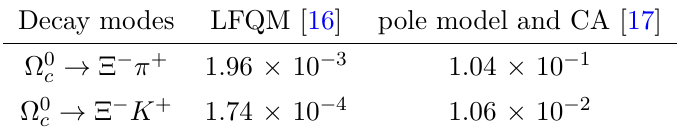
→ Ω − π + is 9% according c